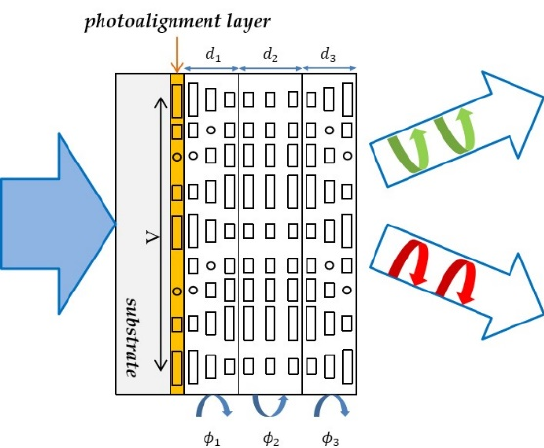
Figure 5. The structure of three-layer multi-twist PG, (d1, d2, d3) = (0.9, 1.32, 0.88) µ m, and the corresponding twist angle ( Φ 1 , Φ 2 , Φ 3 ) = (69.4°, 3.7°, 64°).